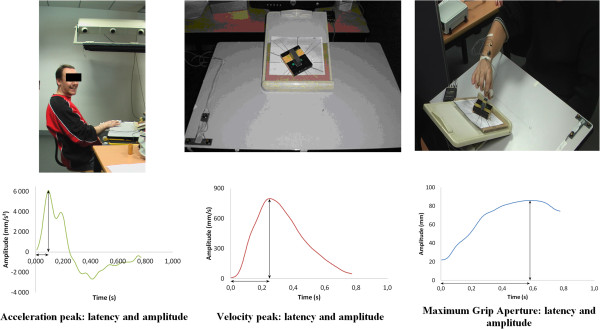
Kinematic task (set-up and kinematic parameters).